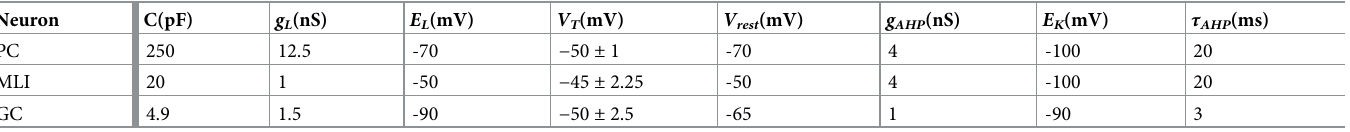
Table 1. The parameters of single cell